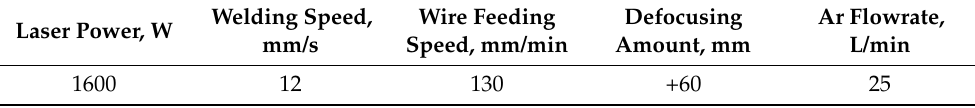
Table 7. Welding parameters to survive the welding processes. Welding Laser Power, W